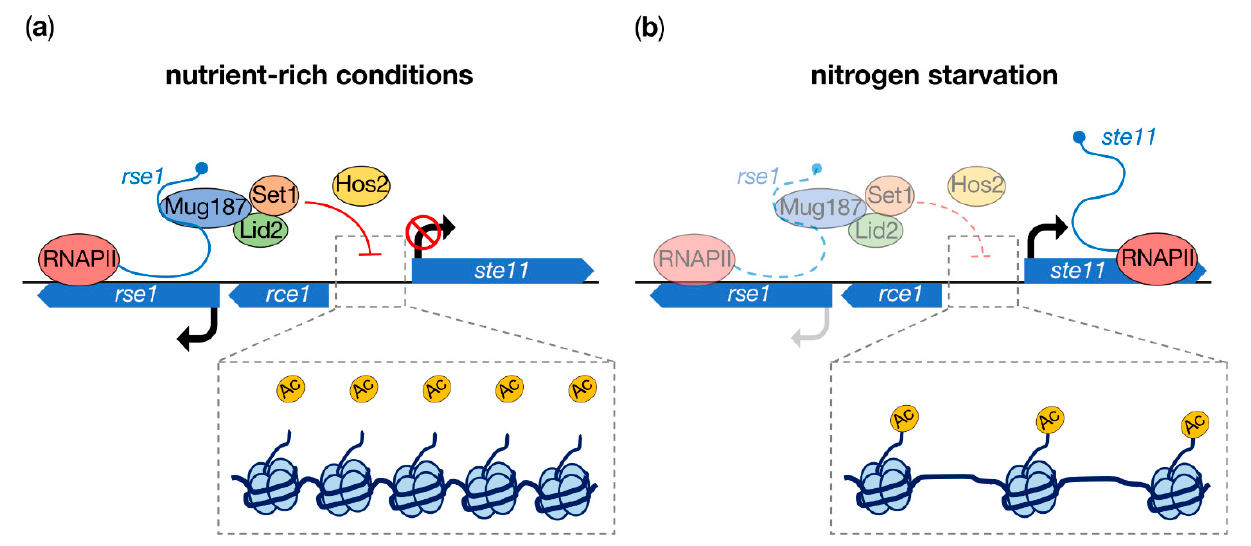
Figure 1. rse1 -dependent repression of ste11 + involves histone deacetylation. ( a ) In nutrient–rich conditions, the lncRNA rse1 recruits Mug187, Lid2 and Set1 to promote histone 3 lysine 14 (H3K14) deacetylation by Hos2 at the promoter of ste11 +, thereby preventing its induction. An array of hypoacetylated nucleosomes upstream the ste11 + gene is depicted in the insert. ( b ) Upon nitrogen starvation, decreased levels of rse1 favor transcription of ste11 +, most likely as the consequence of lower nucleosome occupancy and higher H3K14 acetylation in the gene promoter. Whether the lncRNA rce1 inhibits expression of rse1 in this context remains to be investigated.